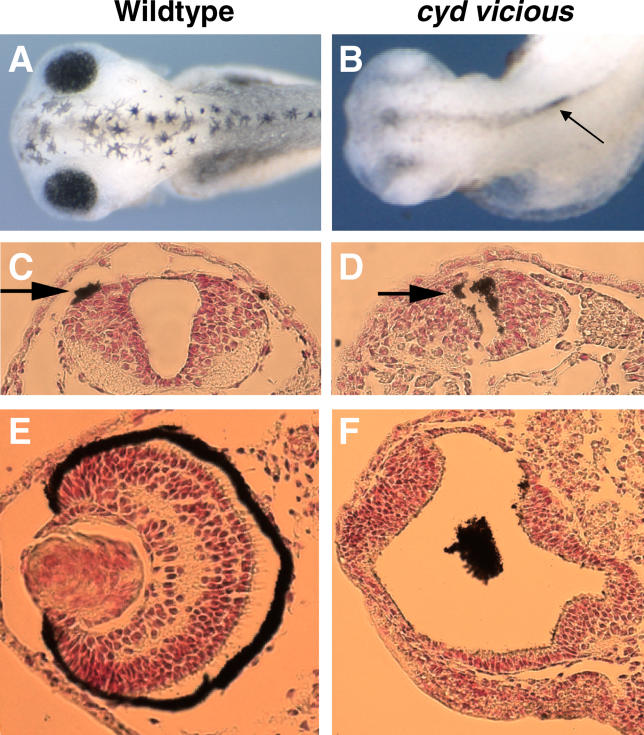
The Mutation cyd vicious Displays Neural Crest and Eye DefectsBrightfield images of stage ~38 outcrossed sibling wild-type embryo (A) and gynogenetic cyd embryo (B). Likely neural crest–derived pigmented cells (arrows, [C] and [D]) fail to migrate in cyd, and instead populate the lumen of the neural tube. St. 40 wild-type eye (E) displays laminar organization surrounded by prominent pigmented epithelium. cyd eyes form a poorly laminated ball of neural retina surrounding a central mass of pigmented tissue, and no lens tissue is visible (F).